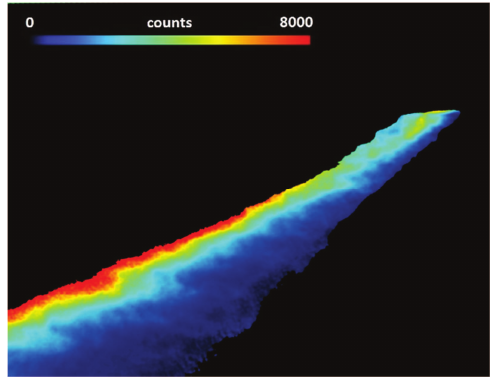
Fig. 9. LIF/Mie ratio (based on averaged